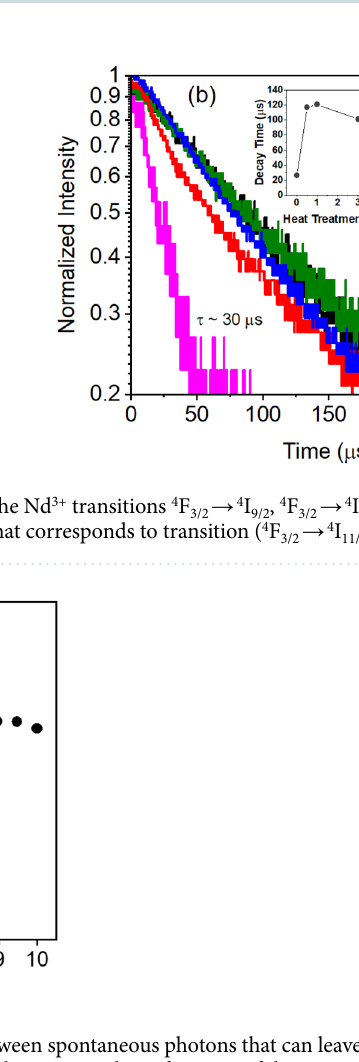
mean-free-path within the range of transport lengths determined from the CBS measurements. There were no constraints for the size of the simulation box, except for the plane of incidence of photons, located at z = 0. To simulate an incident photon on the sample, the initial polar and azimuthal angles of the displacement vector of the photon are chosen to be (θ 0 , φ 0 ) = (0, 0), where θ and φ are the polar and azimuthal angles, respectively. In the model, the pump photon can either be scattered through the sample or be absorbed and give rise to a secondary photon. At each scattering event, the direction of propagation of the photons changed through θ and φ. The absorption probability was set in accordance with the absorption cross section of the sample at 808 nm. The secondary photon was allowed to randomly scatter through the sample with the same initial mean-free-path. The simulation was finished if either the secondary photon was able to reach the surface or if the secondary photon was scattered inside the sample for more than 10,000 times. The simulation was repeated for 5000 pump photons. The ratio between secondary photons that could reach the surface and would be able to be detected (N e ) to those generated within the sample (N 0 ) is shown in Fig. 7, as a function of the transport mean-free-path. The simulation shows that the N e /N 0 ratio is independent of the mean-free-path. Thus, spontaneous emission would not benefit from the reduction of photons mean transport length, that was observed from CBS characterization. For this reason, PL enhancement may be due to the reduction of nonradiative losses, that may be attributed to the incorporation of Nd 3+ ions into the structure of crystallites that were grown during the annealing treat- ments. This is corroborated by XRD results, since the Nd 2 Ge 2 O 7 phase is present in the glass–ceramics even for samples annealed for only 0.5 h. In addition, samples annealed above 3 h, clearly show small sharp features in the PL spectra, which are overlapped to the broad emission band characteristic of the glassy phase. The emerging sharp bands are also an indication that Nd 3+ ions were incorporated into NdO 7 and NdO 8 polyhedra 47 within the structure of the Nd 2 Ge 2 O 7 crystallites that were grown during the annealing treatment. The rise on the lifetime after the annealing treatment is also consistent to the fact the Nd 3+ ions are migrating to specific sites within the crystalline structure of Nd 2 Ge 2 O 7. In this case, for the parent glass, the average distance among Nd 3+ ions is probably, much shorter than in the GCs. Thus, the higher proximity of Nd 3+ ions in the glass enhances the ion- ion interactions causing a reduction in the observed lifetime 48–50 .